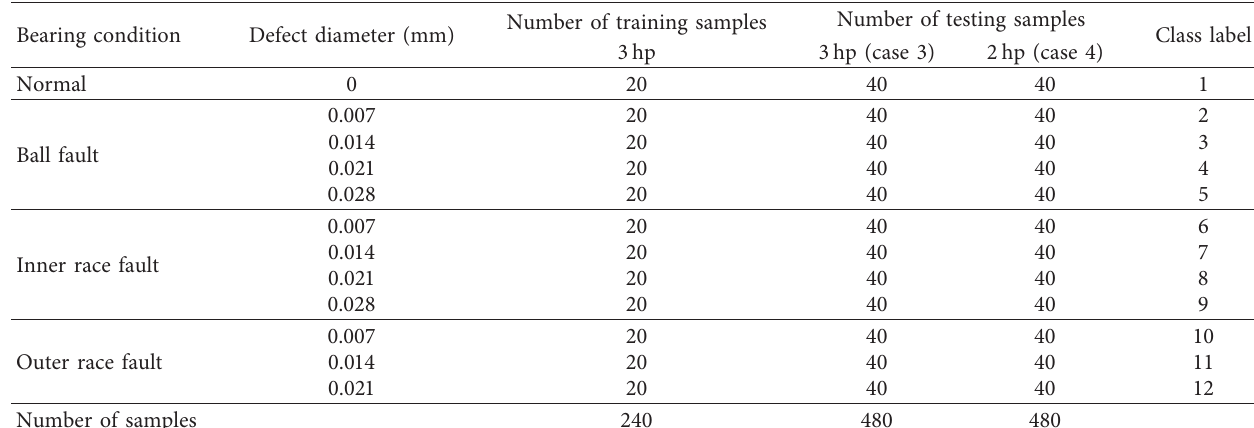
Table 3: The detailed information of the second group dataset.